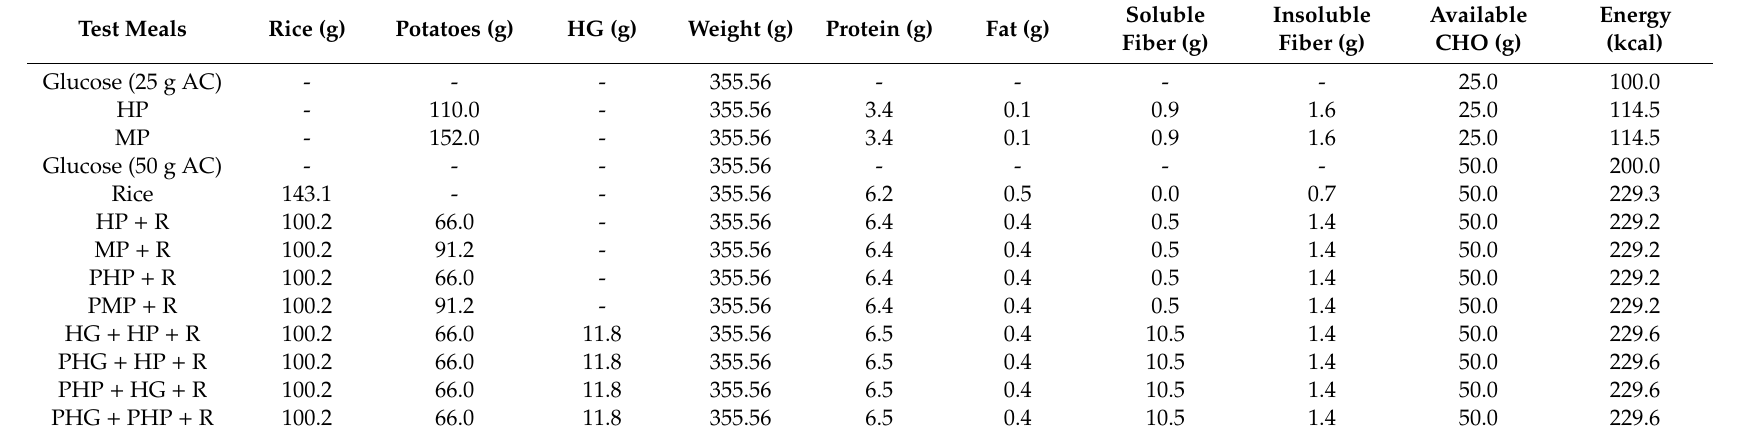
Table 1. Nutritional composition of administered test meals (per